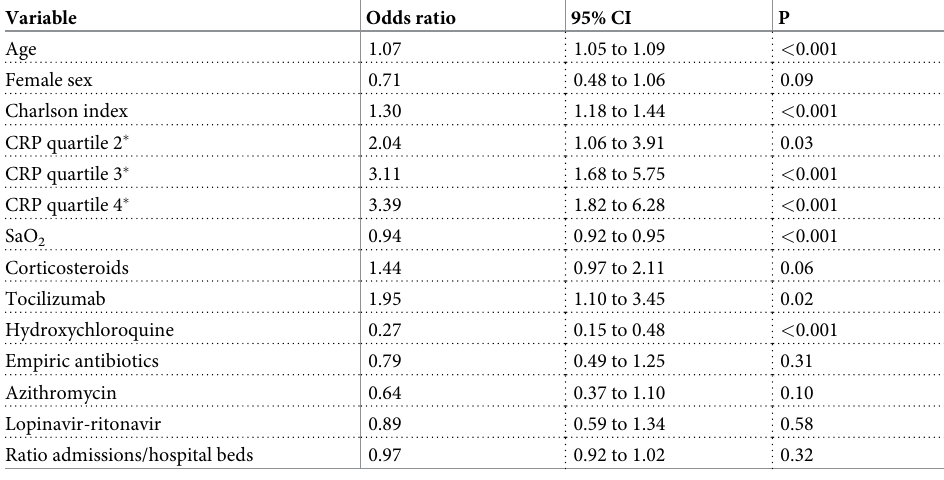
Table 5. Results of the multivariable logistic regression analysis for in-hospital death.